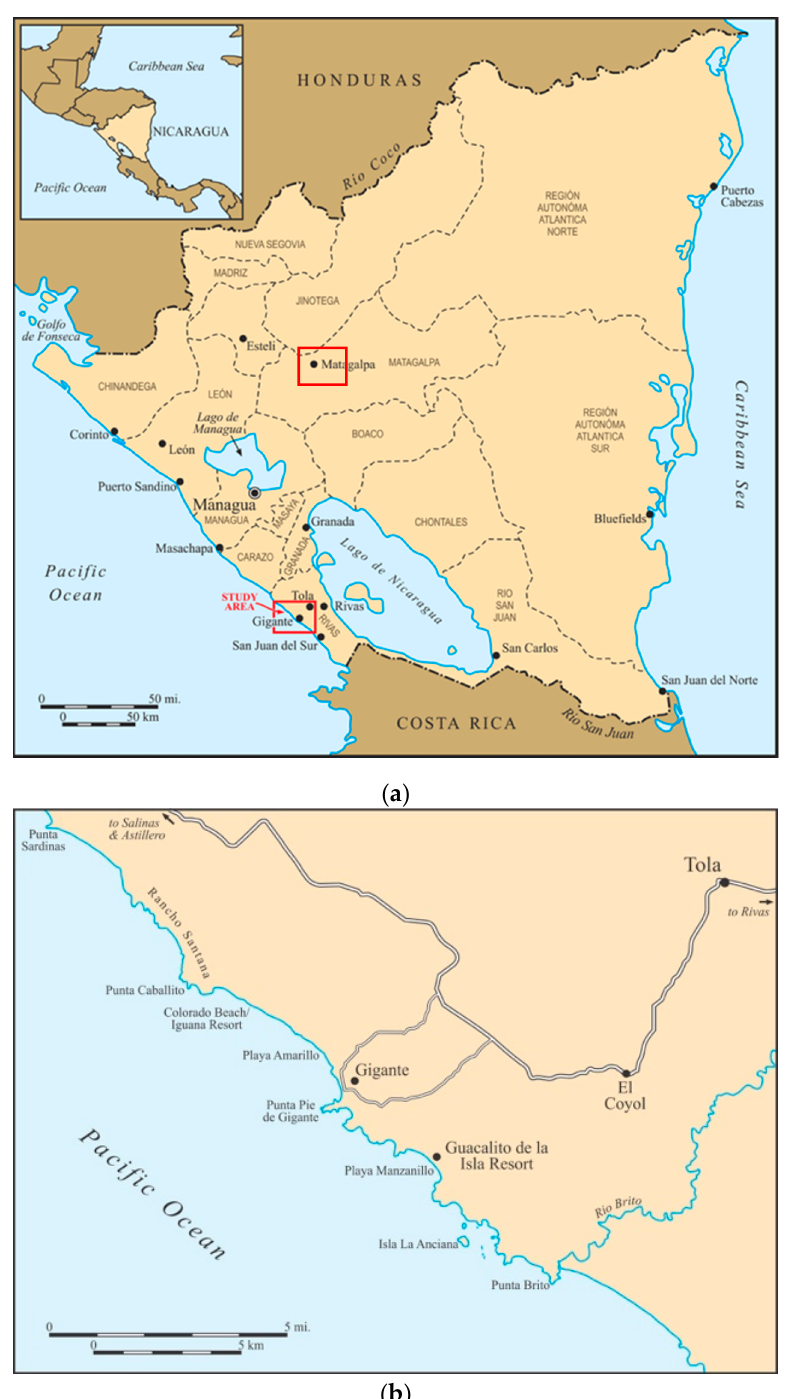
Figure 1. ( a ) Map of Nicaragua and study areas; ( b ) Map of Gigante and coastal Tola.